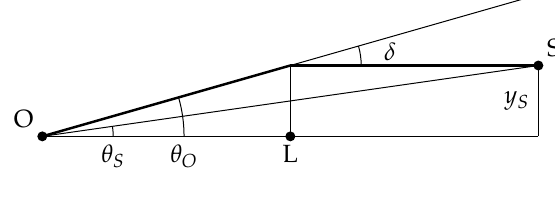
Figure 2. The thin-lens